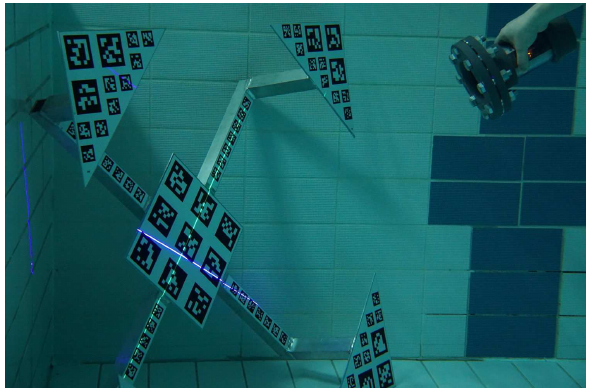
Figure 1: Cross line laser projector in a waterproof housing for underwater